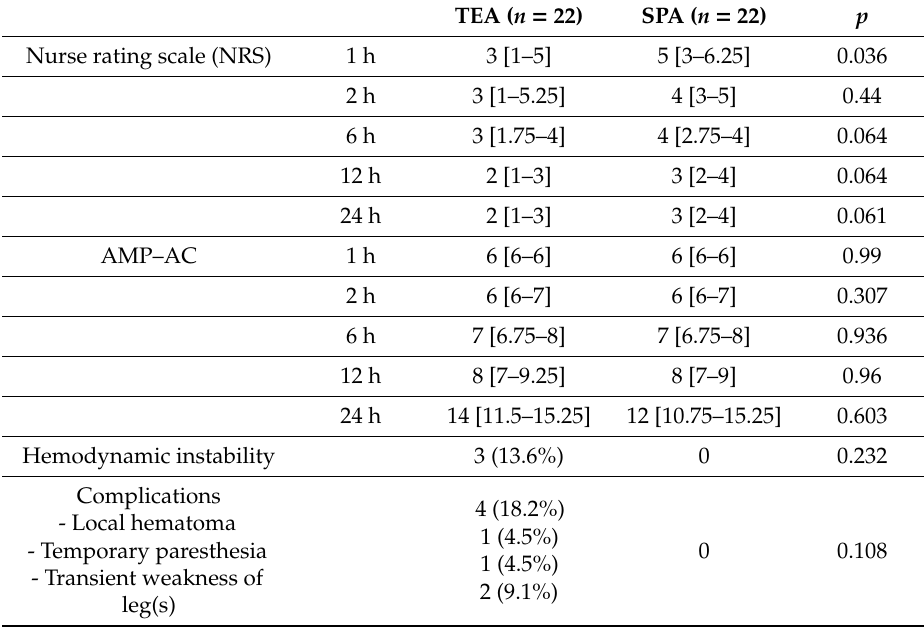
Table 4. Pain scores, mobility, hemodynamic stability,